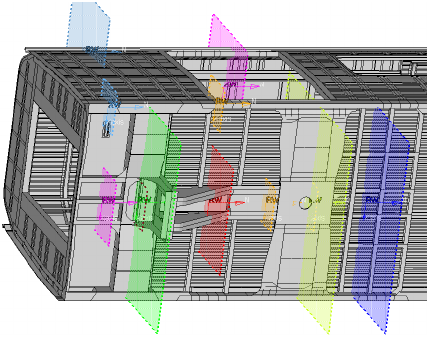
Figure 12. Section force-sensing unit position on the vehicle body